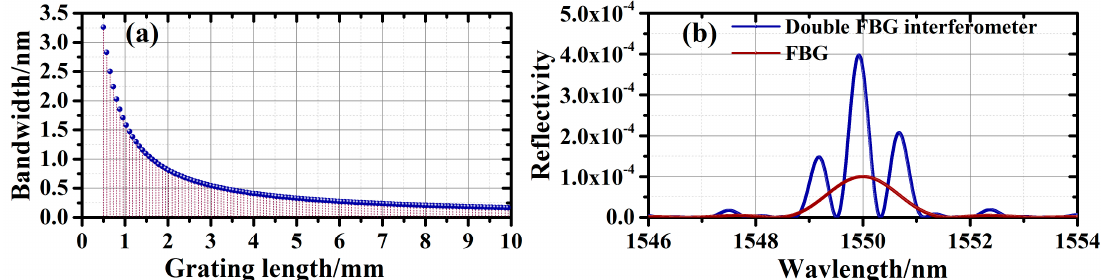
Figure 2. ( a ) Relationship between the grating length and the bandwidth of the reflection spectrum; ( b ) simulated single-FBG reflection spectrum and double-FBG interference reflection spectrum.